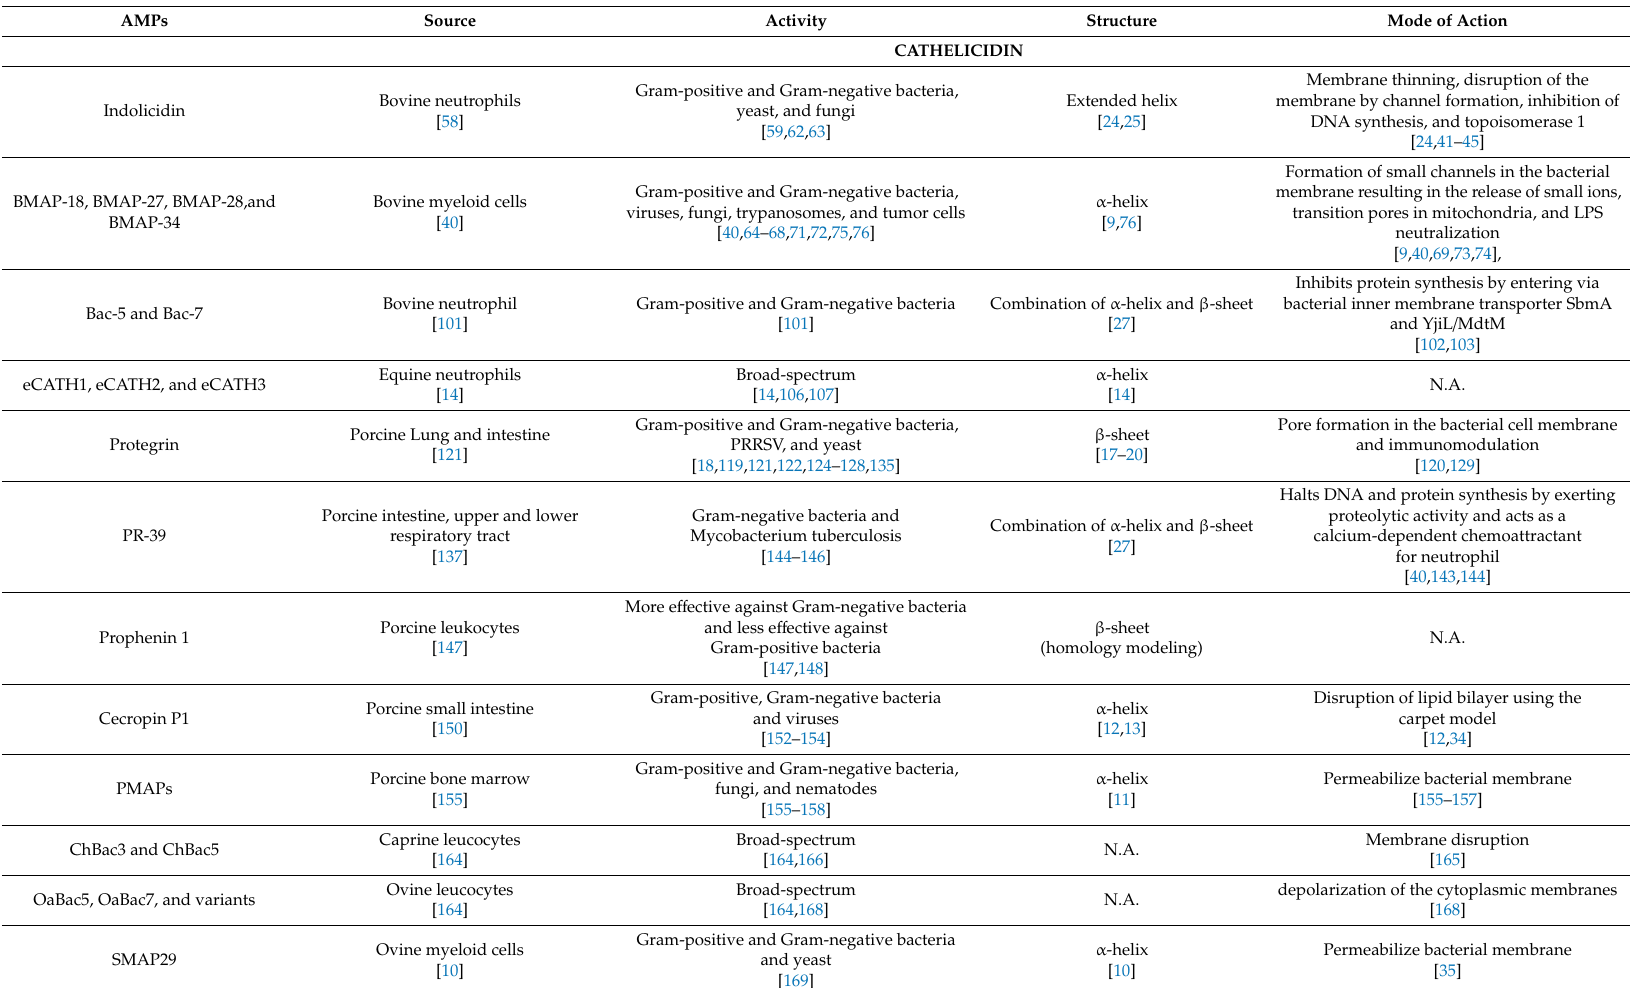
Table 1. Major antimicrobial peptides from farm